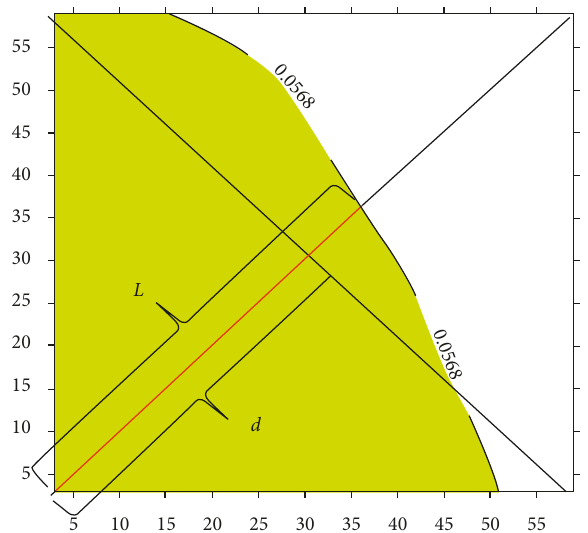
Figure 20: Schematic diagram of distance between the average pressure front and the inlet.